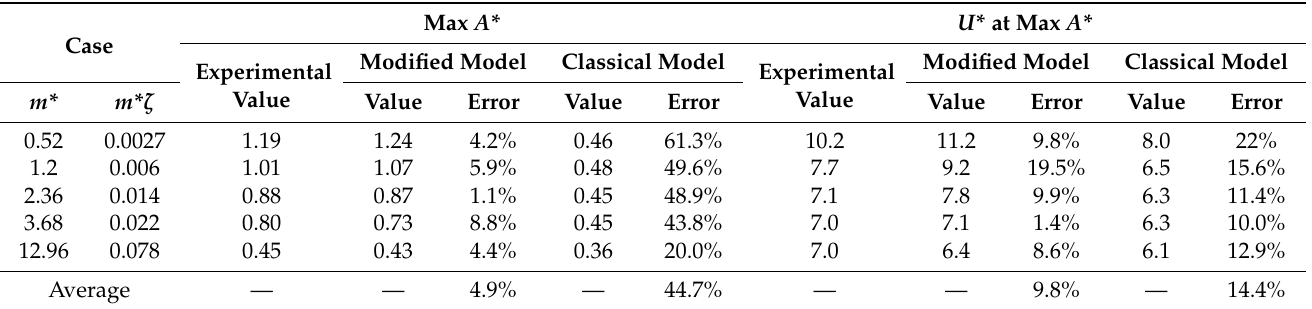
Table 2. Compare of maximum amplitude and the corresponding velocity in experimental and calculation